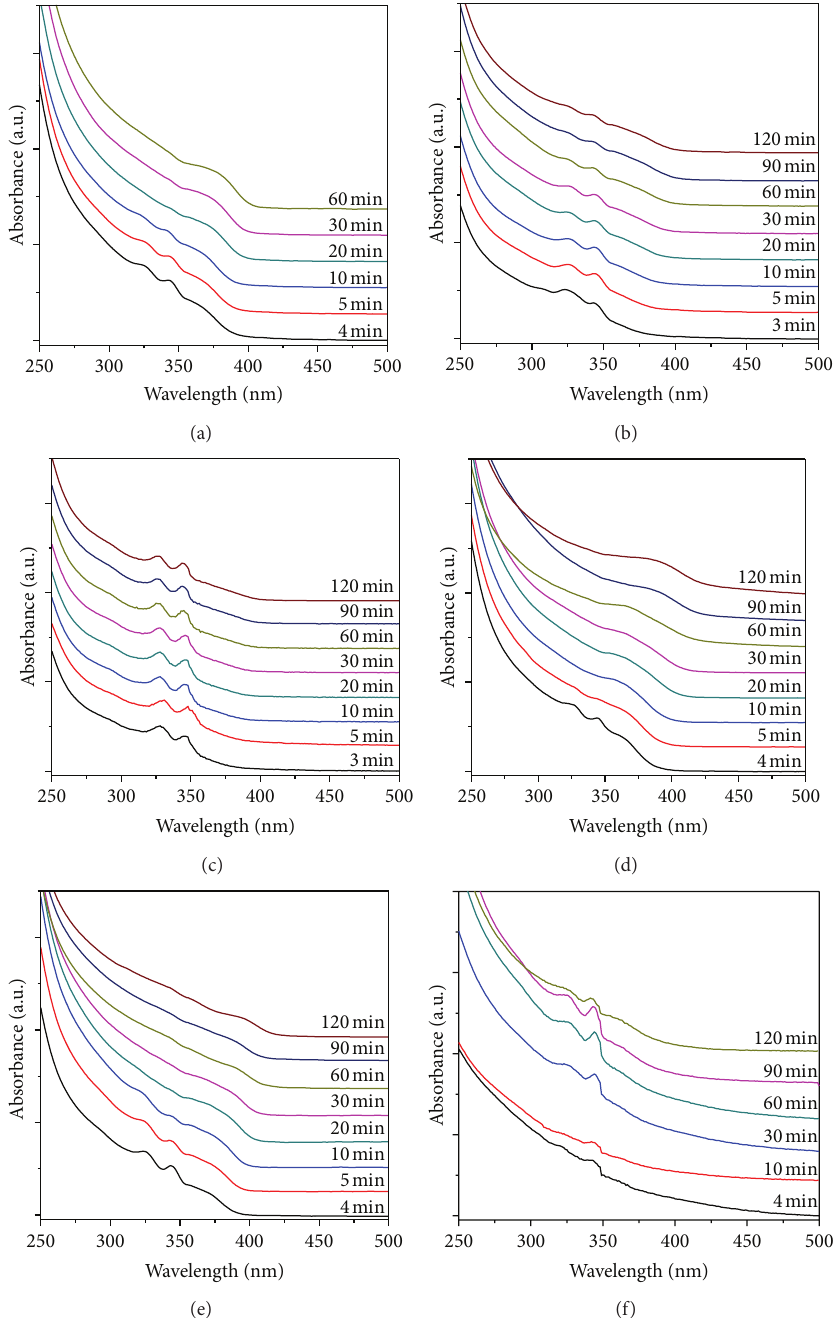
Figure 1: UV-Vis absorption spectra of ZnSe NCs synthesized at 220 ∘ C using different Zn precursors: (a) 0.4mmol ZnAc 2 , (b) 0.4 mmol Zn(NA) 2 , (c) 0.4mmol ZnSt 2 , (d) 0.6 mmol ZnAc 2 , (e) 0.6mmol Zn(NA) 2 , and (f) 0.6 mmol ZnSt 2